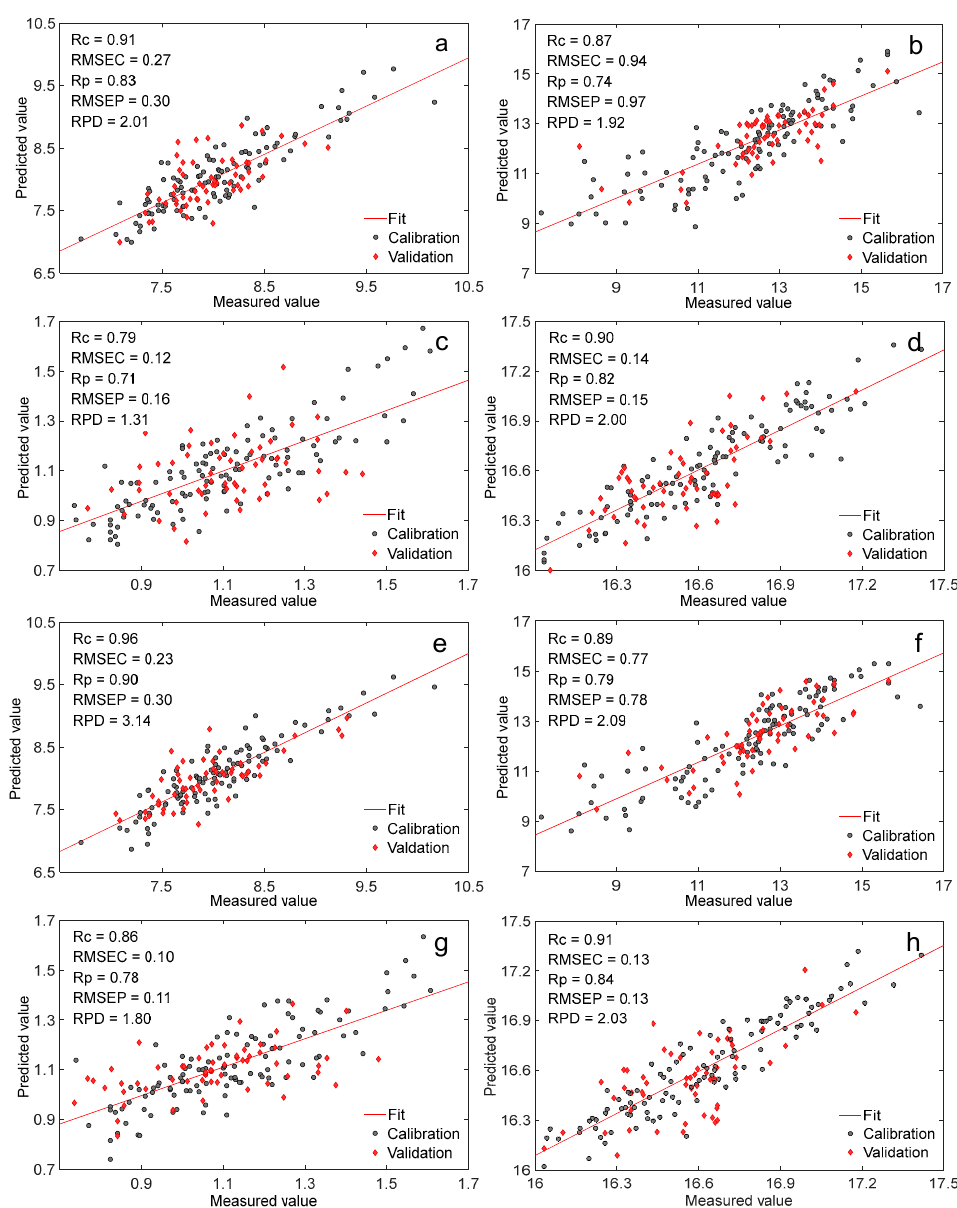
Figure 4. Scatter plots of NIR online analysis model for raw and crushed forage maize by the home- built spectrometer (( a , c , e , g ) crude protein, moisture, crude ash, and energy models of raw forage maize; ( b , d , f , h ) crude protein, moisture, crude ash, and energy models of crushed forage maize).